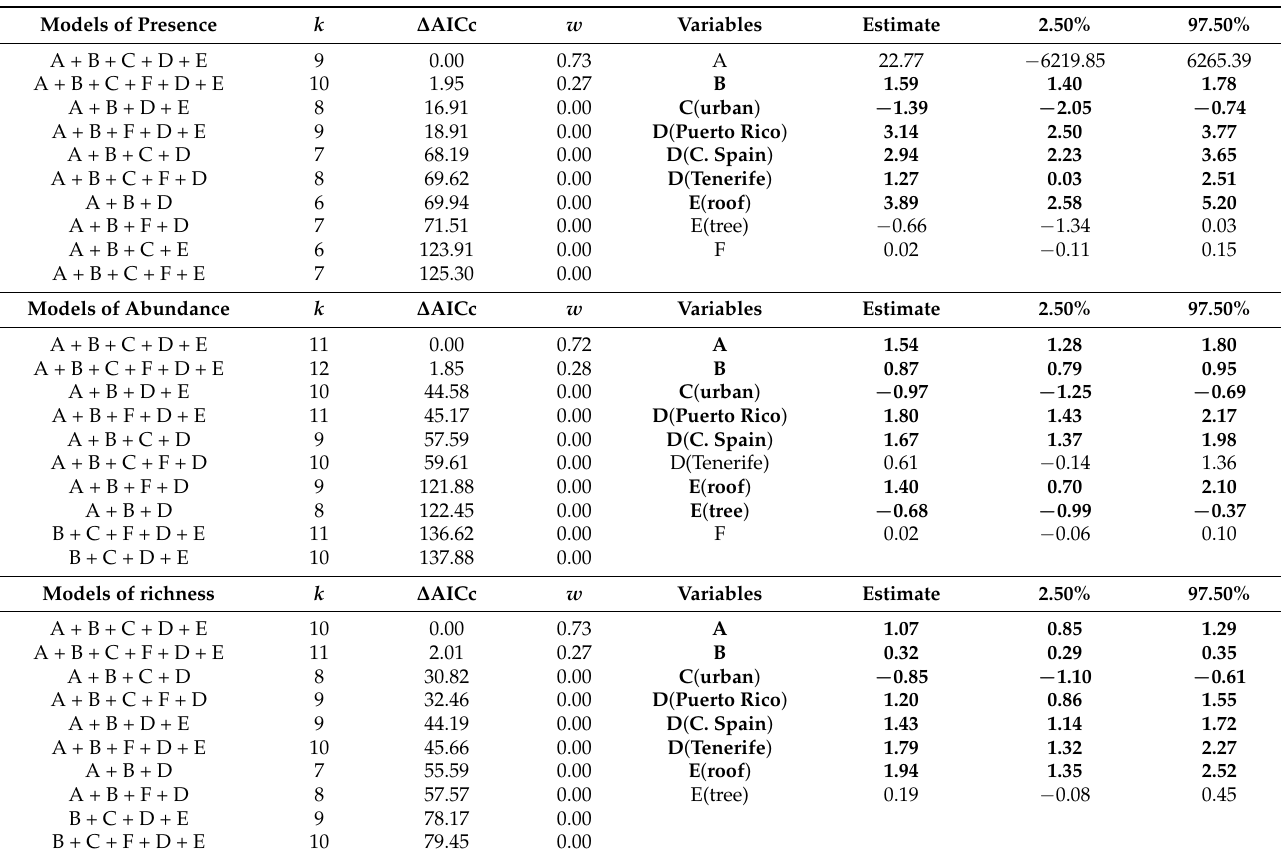
Table 2. Models obtained to assess the effects of different variables (see footer) on the presence, abundance, and richness of tenant species at monk parakeet nests. Estimates and 95% confidence intervals (2.5% and 97.5%) were obtained after model averaging. k: number of parameters, ∆ AICc: difference between the AICc (i.e., the Akaike Information Criterion corrected for small sample sizes) of model i and that of the best model (i.e., the model with the lowest AICc), w: Akaike weights. The fit of the model including all variables used in model averaging can be checked in Figure S1. In bold, variables receiving strong support (i.e., the 95% confidence interval did not overlap with zero). The first ten models obtained are